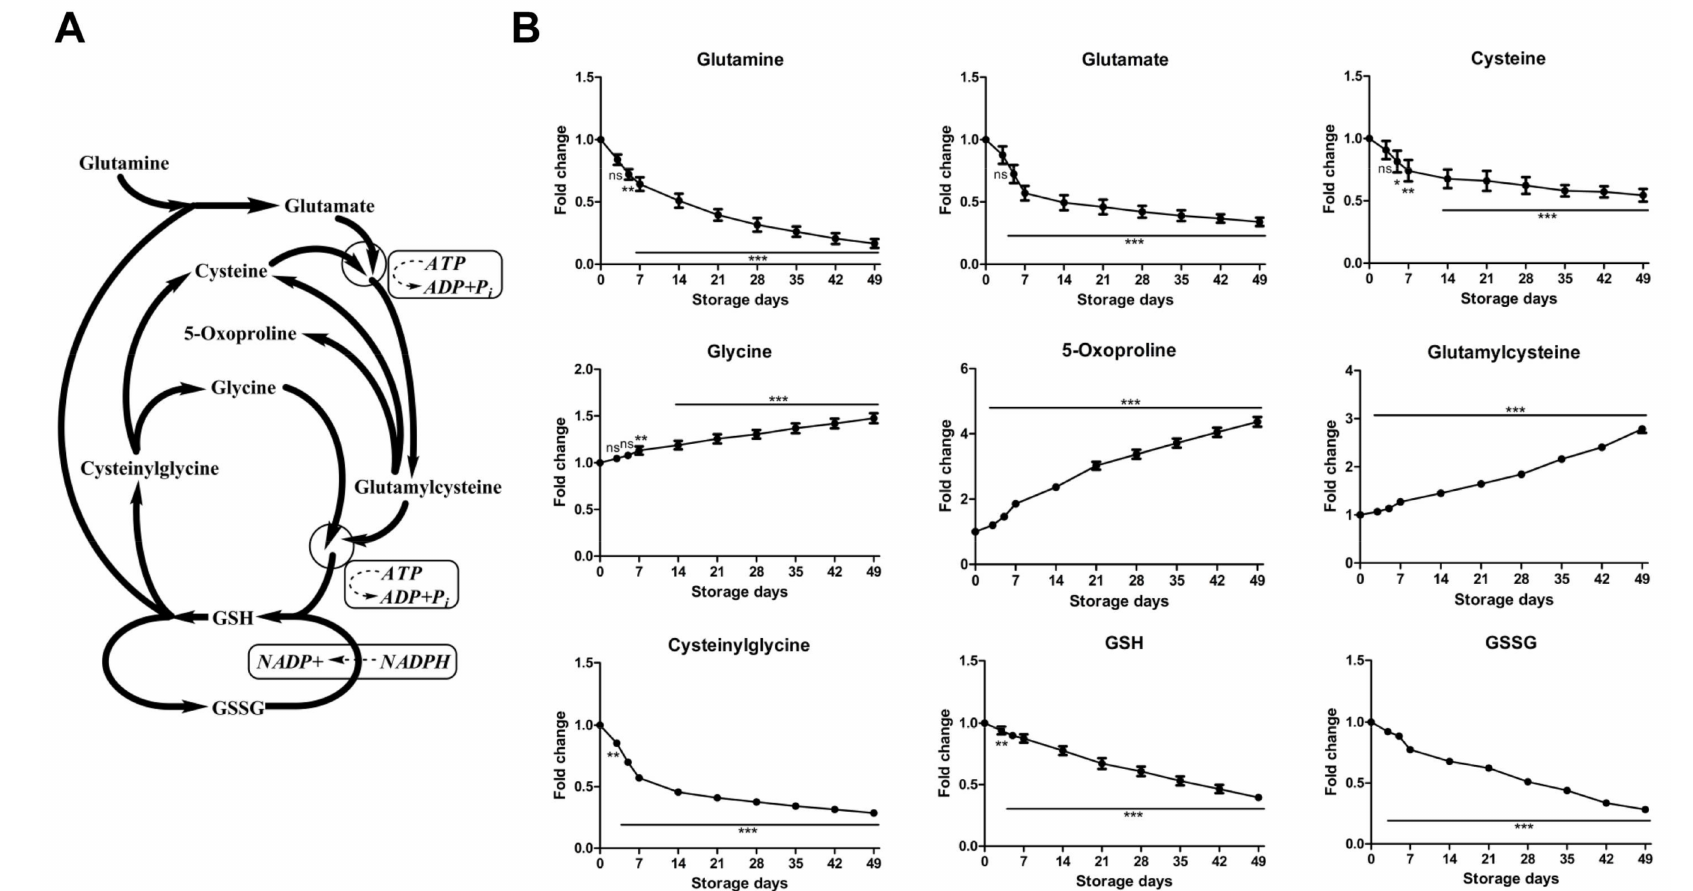
Figure 4. An overview of glutathione homeostasis ( A ) and time-course changes of metabolites involved in this pathway ( B ) during RBC storage in MAP. Fold change was normalized against day 0 controls. Data are mean ± SD ( n = 8); * p < 0.05, ** p < 0.01, *** p < 0.001, ns (not significant), compared with day 0